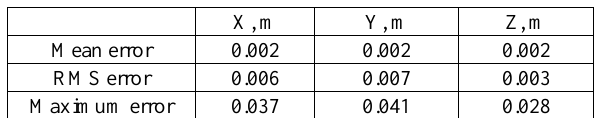
Table 2. Relative accuracy estimation of MLS data adjustment